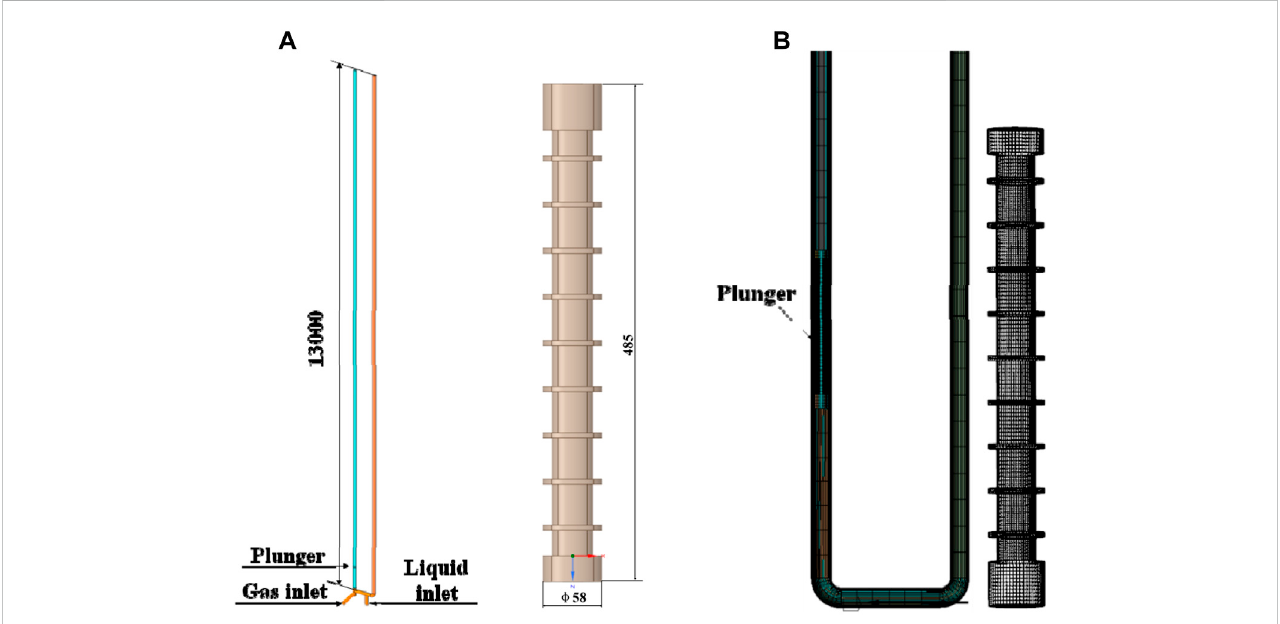
FIGURE 6 U-shaped CFD model for plunger gas lift. (A) . Flow channel model (B) . Grid model.